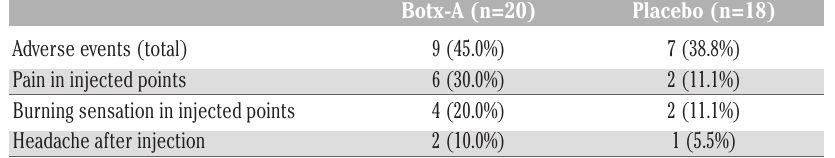
Table 4. Adverse events reported in the studied